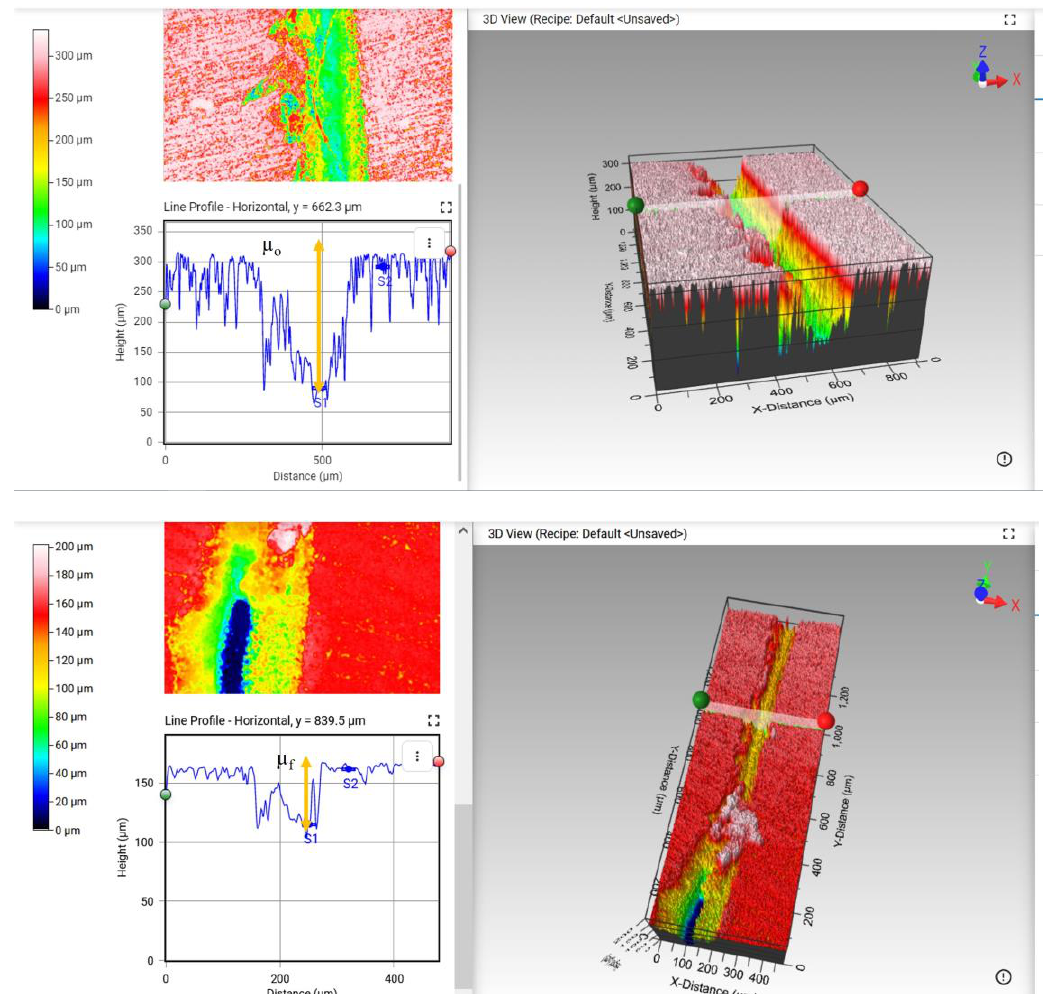
Figure 2 . Depth calculations using Mountain Map Premium 7.1 software before and after the self- healing process. After selecting a region of the crack, the program calculates the difference between the highest and lowest point and provides the depth of the crack.